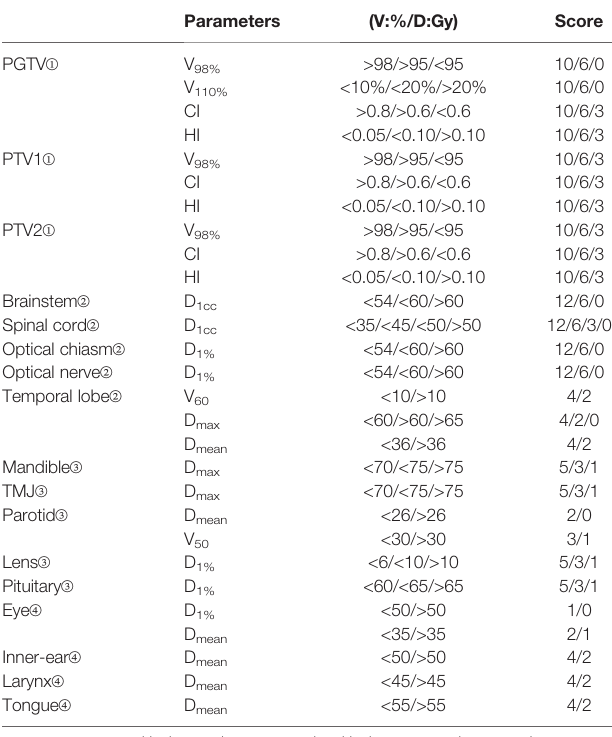
TABLE 2 | The quality metric for nasopharyngeal carcinoma cases including the built-in dosimetric indices and the scoring points for tumor targets and organs at